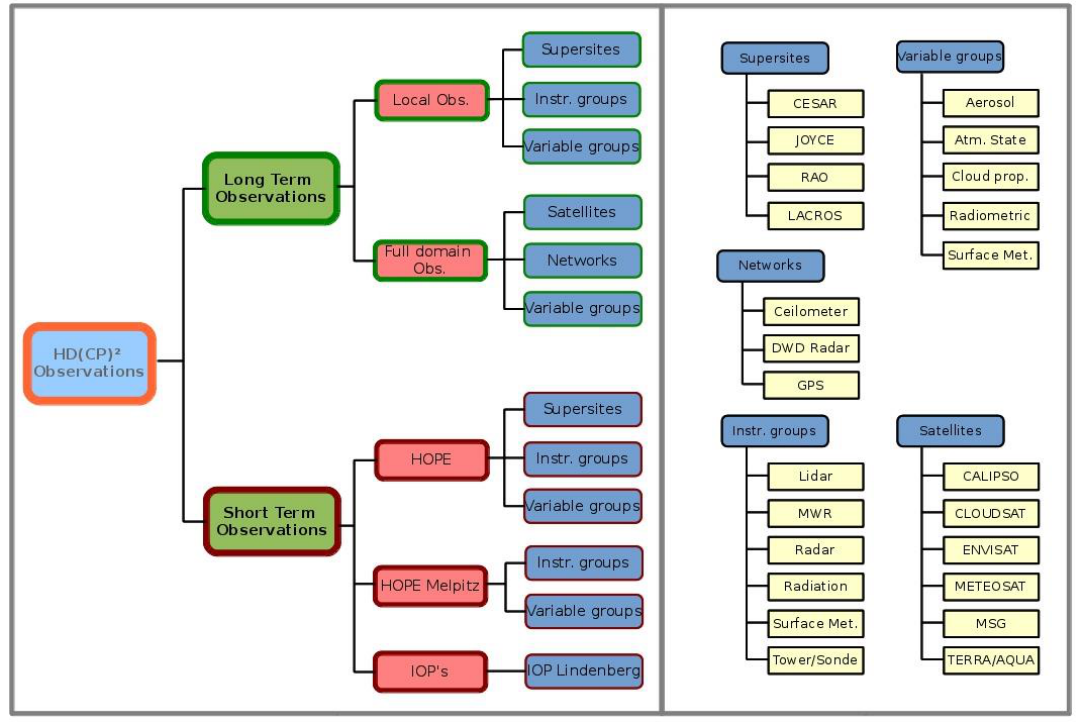
Figure 5. Search tree, following the metadata taxonomy for search keywords.